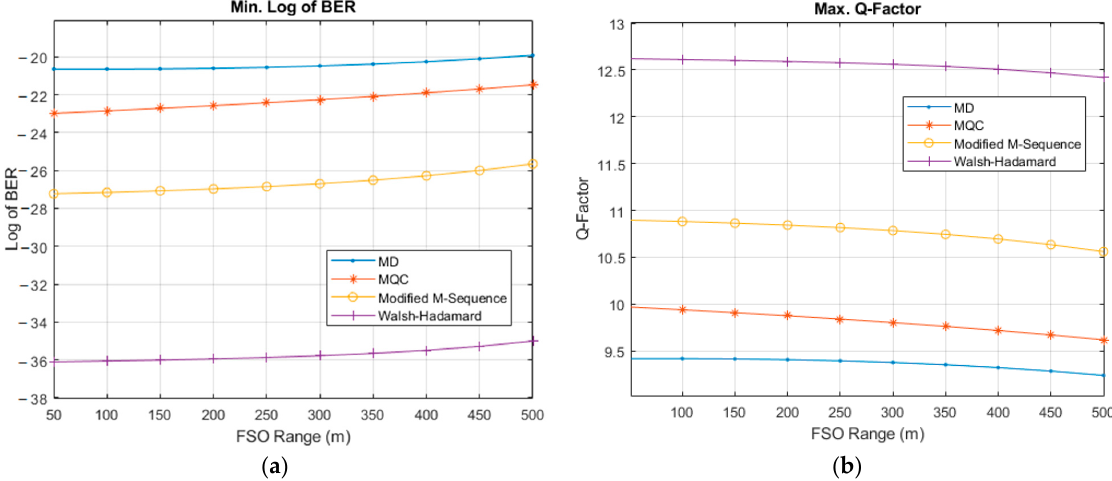
Figure 14. Performance of the system under weak turbulence conditions: ( a ). min. log of BER; ( b ). max. Q ‐ factor.